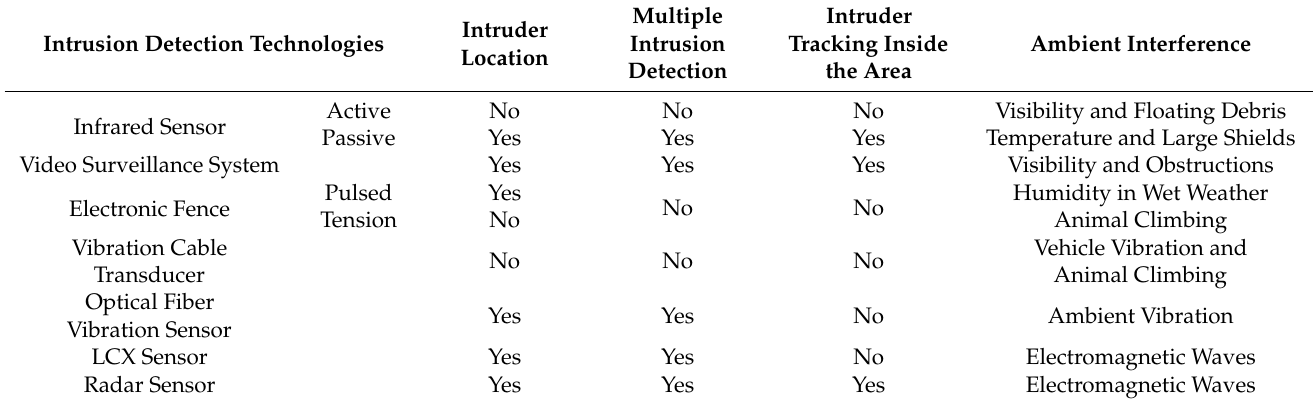
Table 1. Performance comparison of the existing intrusion detection